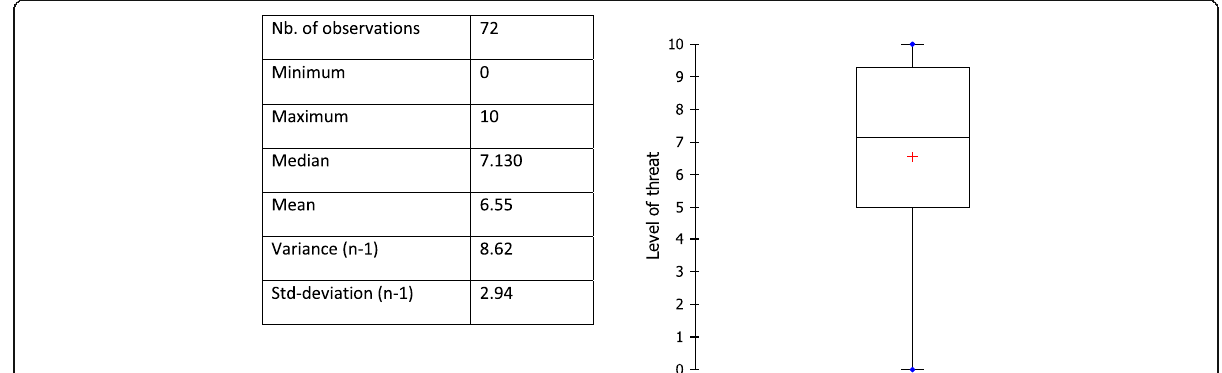
Fig. 7 Answer to the question: “ On this scale, you can set the level of threat that the risks of lahars represent to you? ” (0 = no threat, 10 = a great threat)/Inexperienced people in risk prone areas ( n = 72)